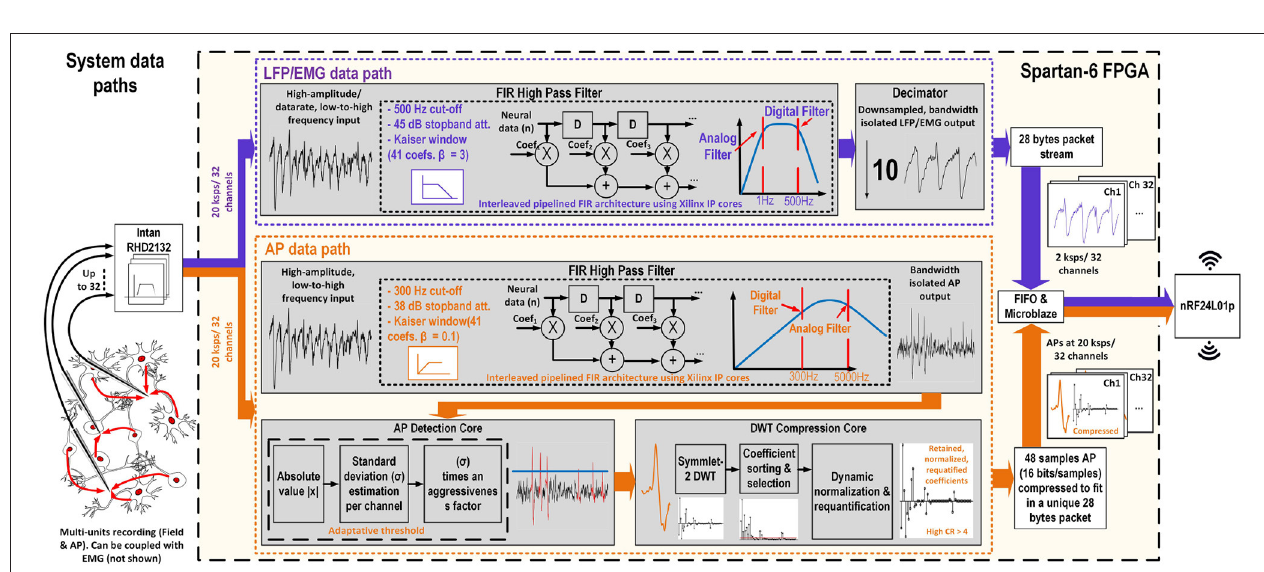
FIGURE 3 | Block diagram of the platform illustrating the data paths for both AP and LFP/EMG signals, and showing the ideal output frequency response for both data paths on the right hand side.